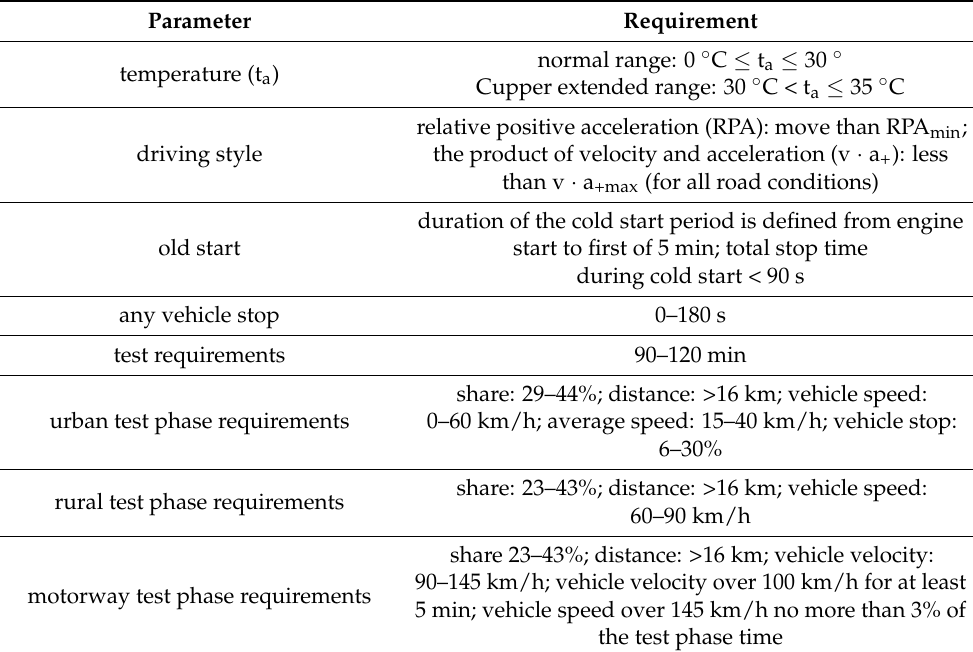
Table 2. Specific requirements of the RDE test [86–88].